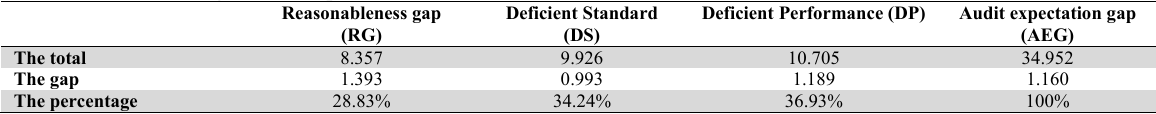
Results from measuring AEG components and AEG in